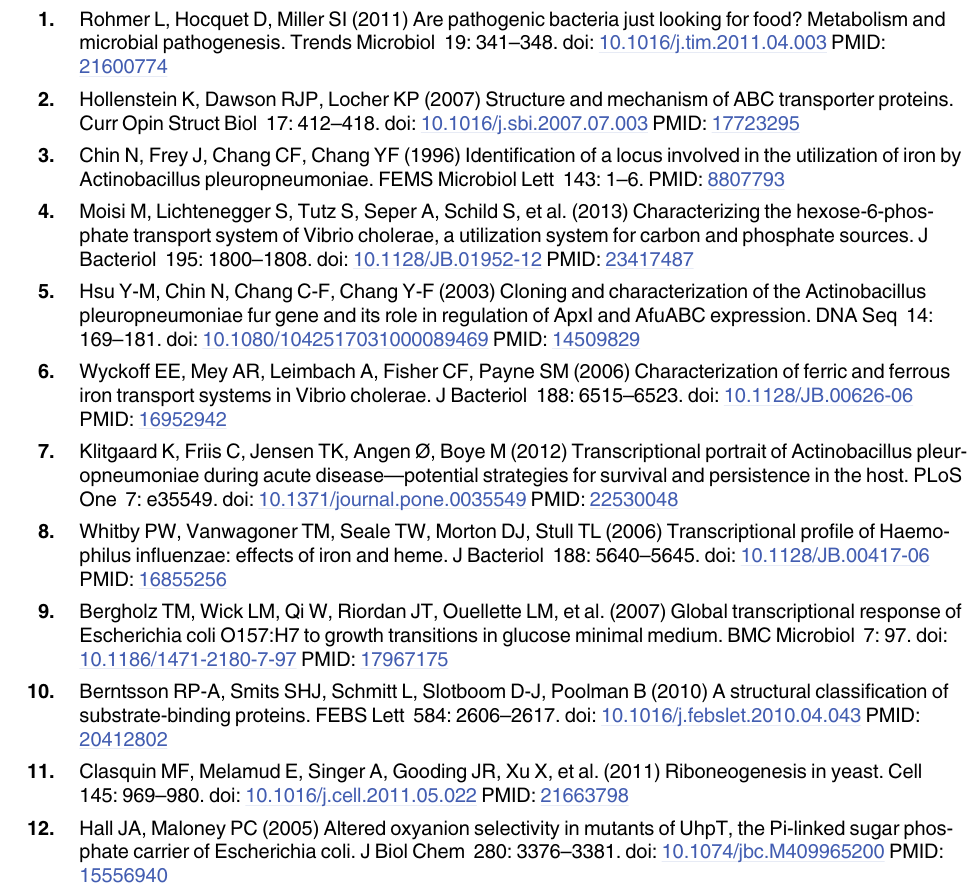
S6 Table. ITC-derived binding constants for C . rodentium AfuA. (DOCX) S7 Table. List of plasmids and strains used in this